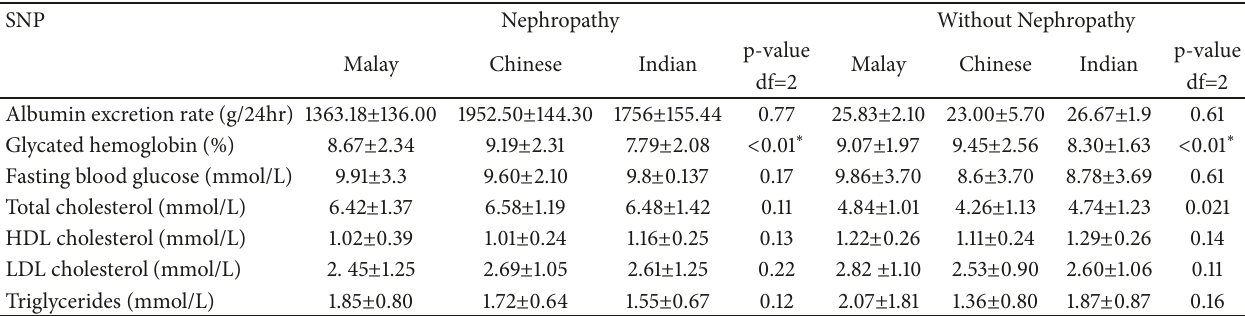
Table 2: Comparison of clinical characteristic across the